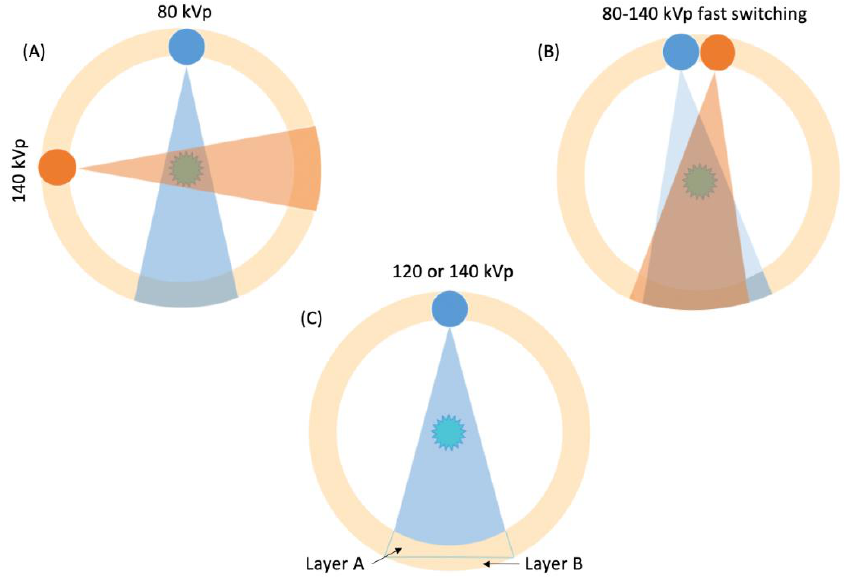
Figure 1. Illustrations showing the main DECT scanning techniques in clinical use. ( A ) Dual-source DECT, consisting of two-source X-ray tubes and the corresponding detectors. ( B ) Single-source DECT consisting of a single tube with rapid kVp switching. ( C ) Detector-based DECT consisting of a single source and a dual-layer detector to obtain low- and high-energy spectra.